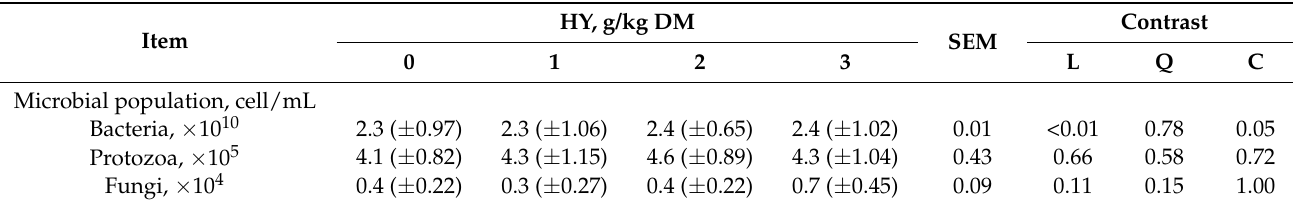
Table 5. Effect of HY supplementation on rumen microorganisms in growing beef